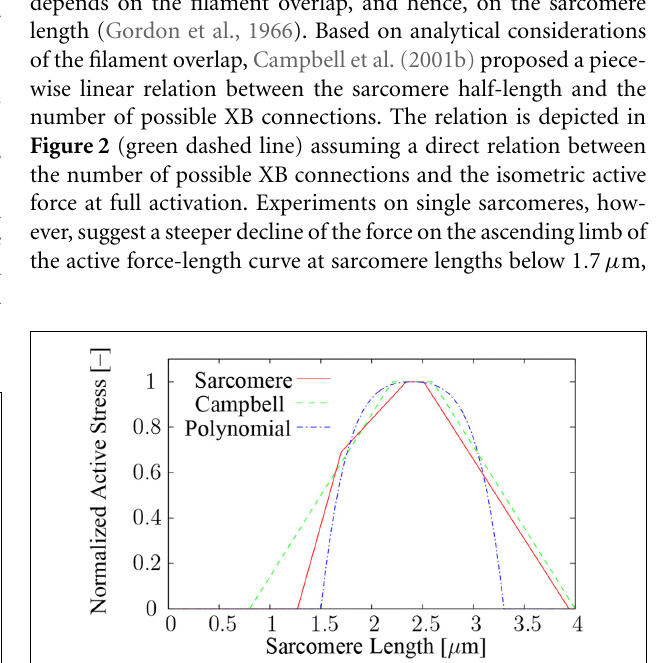
FIGURE 2 | The relation between the normalized maximum isometric active stress and the sarcomere length. Plotted is the experimentally determined force-sarcomere length relation for cat skeletal muscle (Rassier et al., 1999) (red solid line), the piecewise linear relation of Campbell et al. (2001b) (dashed green line), and the fourth-order polynomial of this work (dot-dashed blue